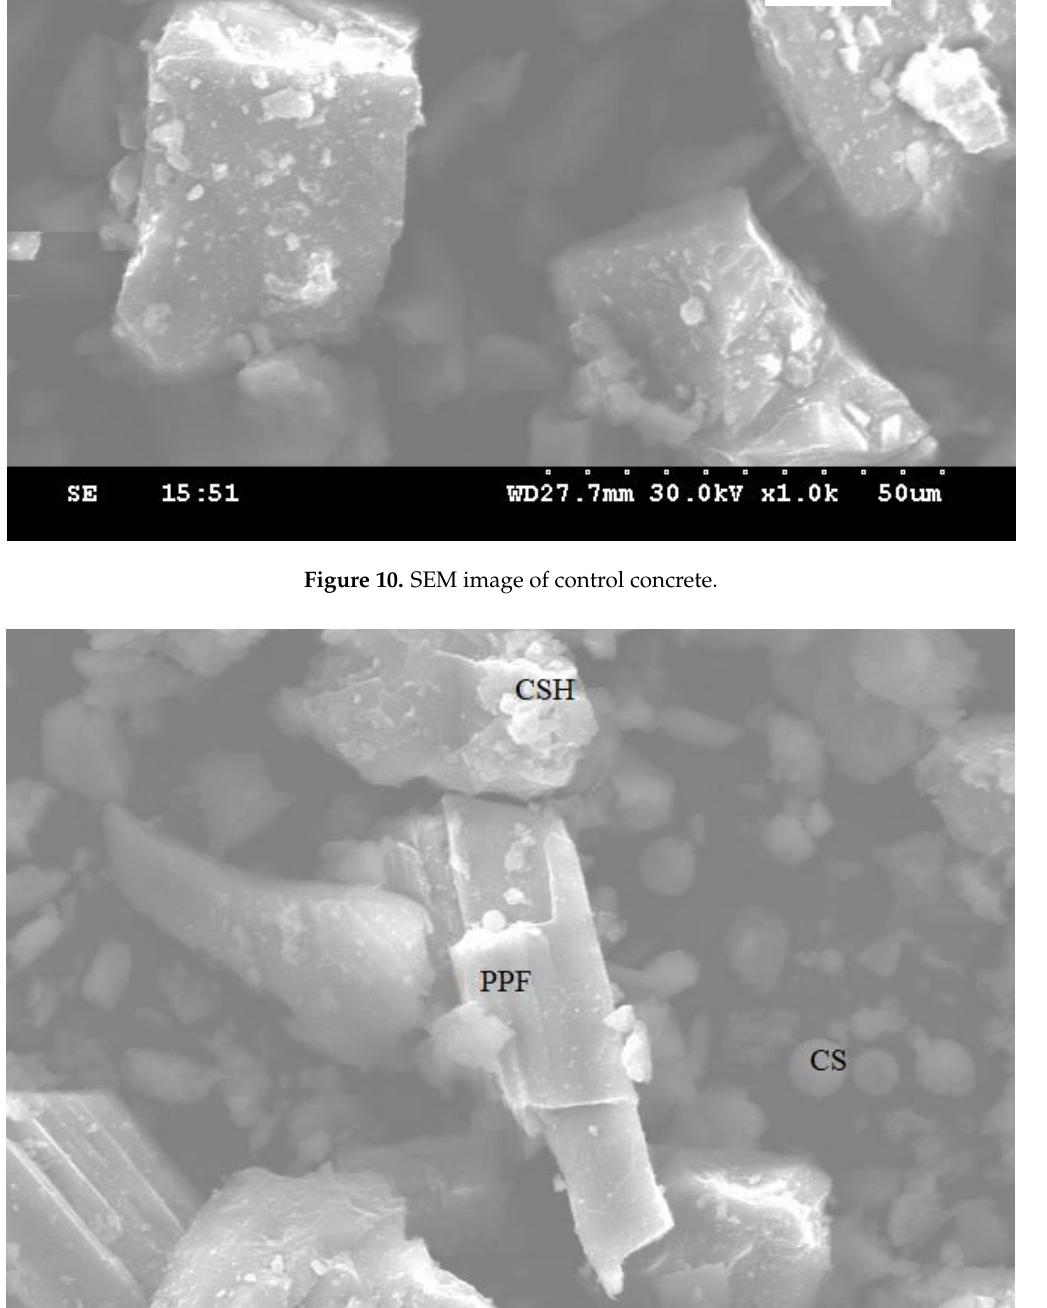
Figure 11. SEM image of PPF concrete.